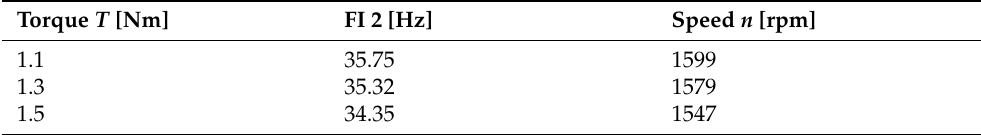
Table 1. Torque at Frequency Inverter 2 (FI 2).